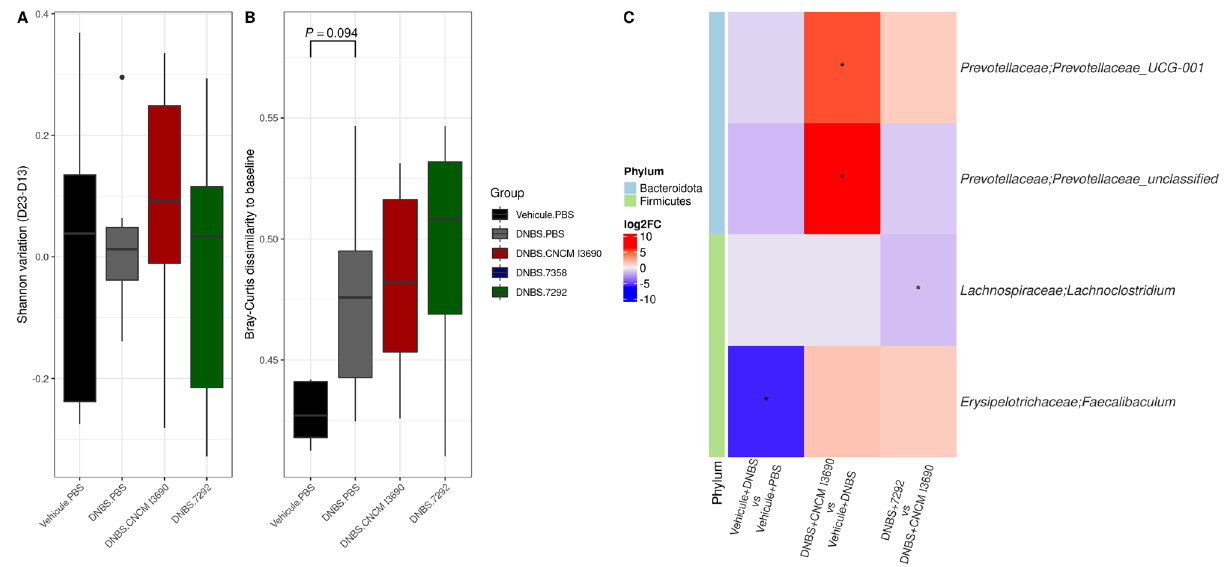
Figure 11. Effect of DNBS and EPS variation on gut microbiota. A) Genus-based Shannon index (Mann– Whitney test; B) Within-mice Bray–Curtis dissimilarity to D13 (Mann–Whitney test) C) Differentially abundant genera were identified using Deseq2 based and between-group effects with adjustment for D13. *FDR < 0.1. Red indicates higher abundance in the first group at D23 versus D13 compared to second group at D23 versus